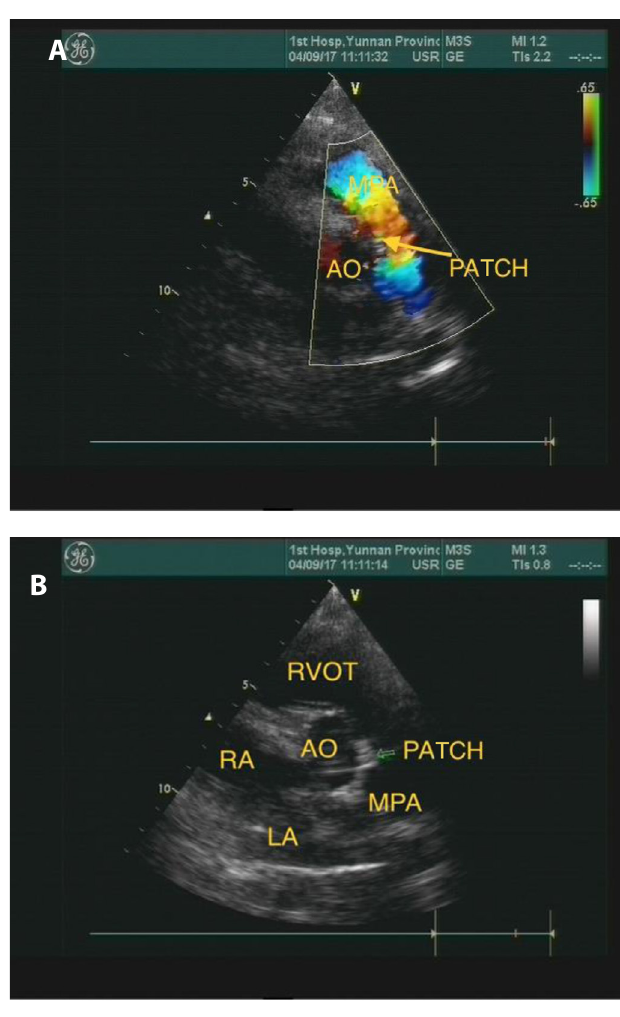
Fig. 3 – Post-operative ECHO images. AO=aorta; LA=left atrium; MPA=main pulmonary artery;